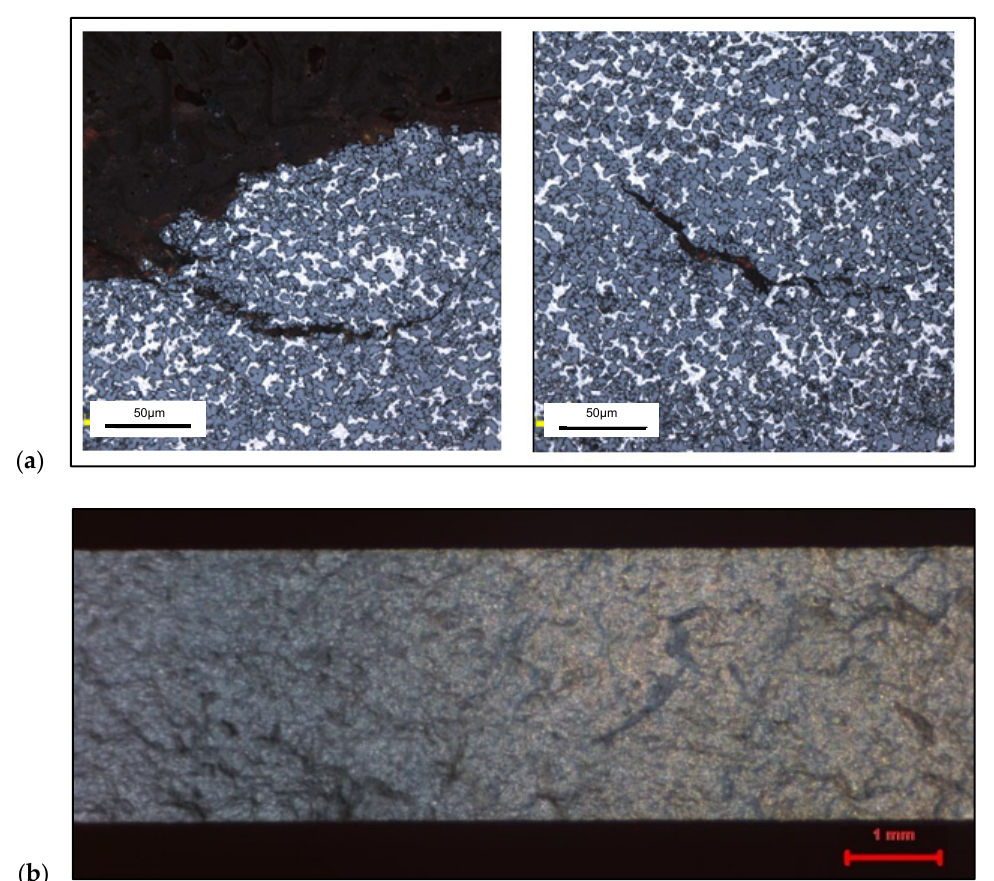
Figure 5. ( a ) Cracking under the effect of the tensile force on the RS Al–50%Si alloy, and ( b ) the cracked surface on the alloy sample.